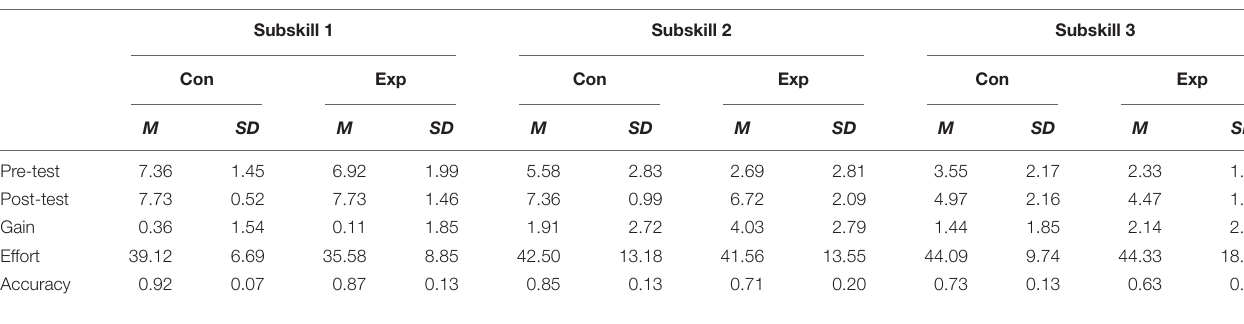
TABLE 4 | Descriptive